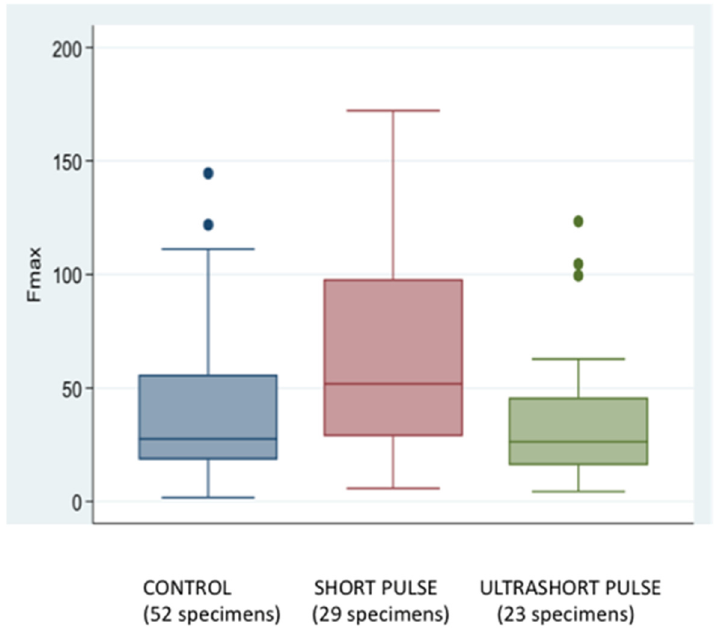
Figure 4. Box plot of F-max by the